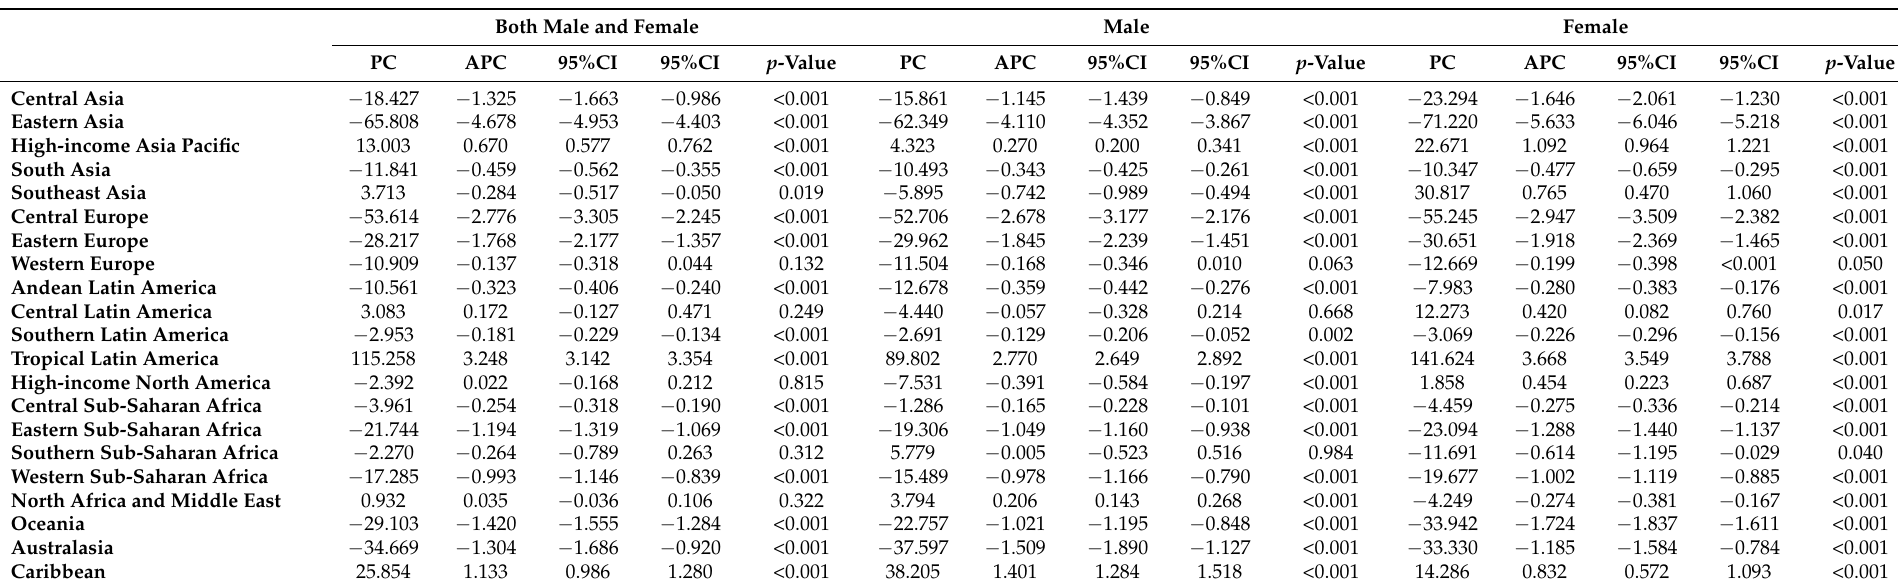
Table 5. Percentage change and annual percentage change of disability adjusted life years of urolithiasis stratified by gender and 21